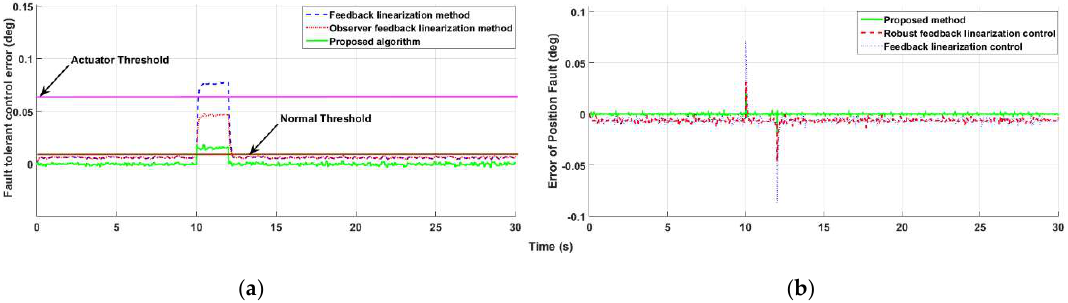
Figure 21. Actuator-sensor fault condition: ( a ) kinematics end-effector position RMS error and ( b ) end effector position in the XYZ plot.